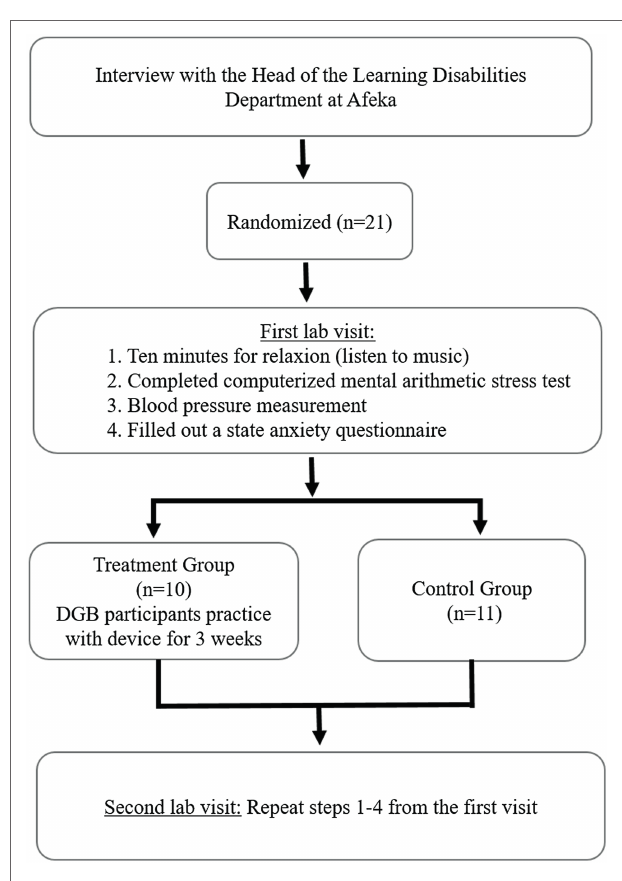
FIGURE 2 | Experimental